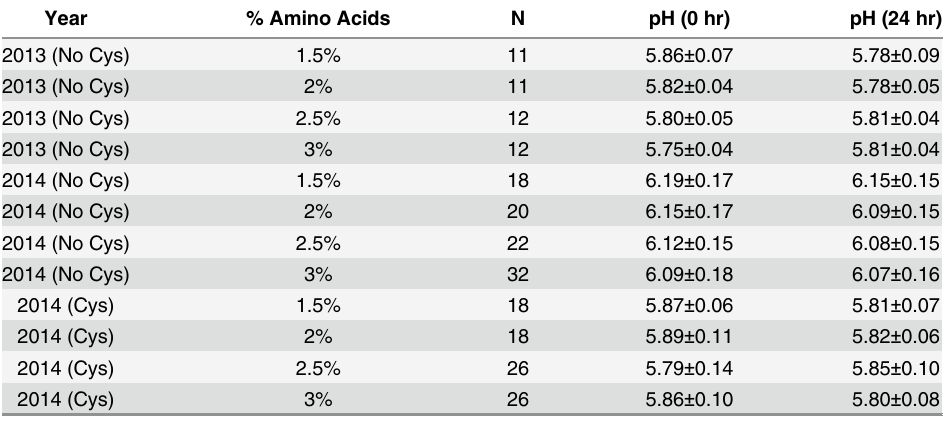
Table 2. pH for Study Solutions in Study